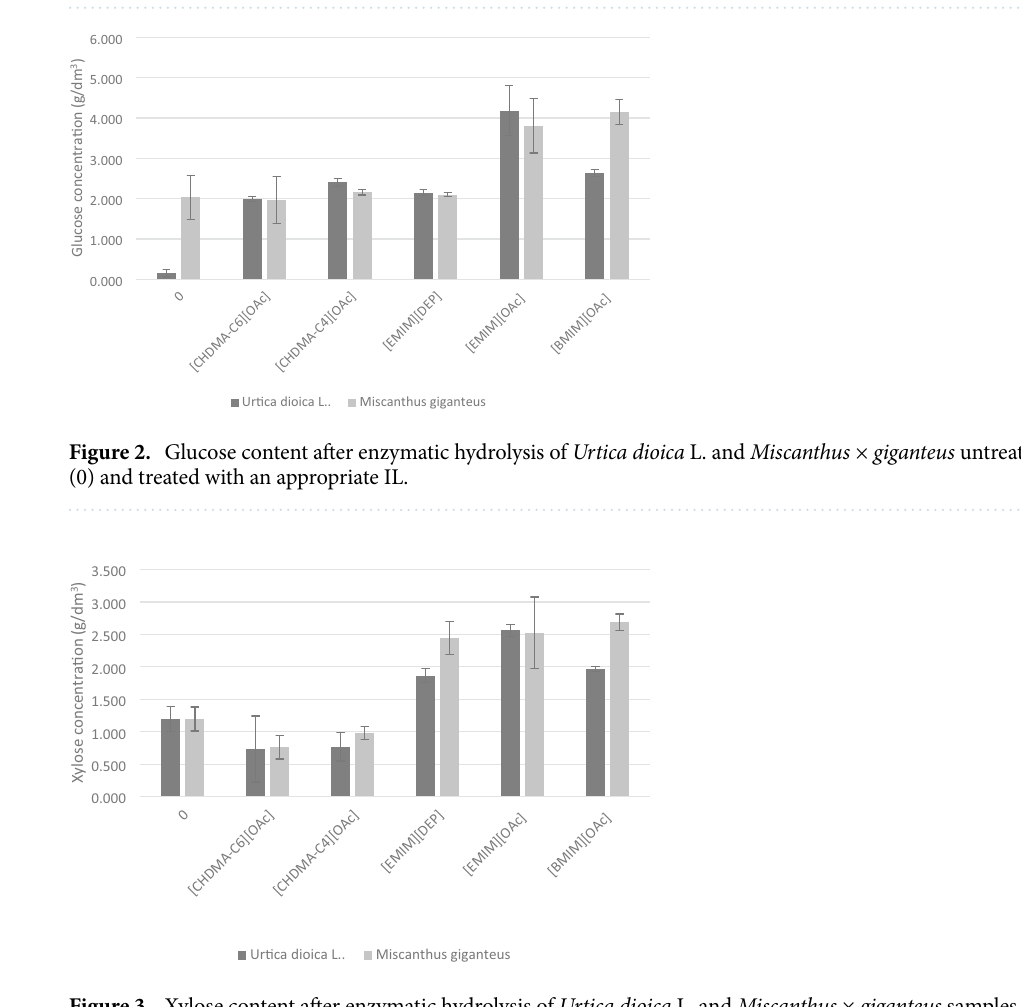
Figure 3. Xylose content after enzymatic hydrolysis of Urtica dioica L. and Miscanthus × giganteus samples untreated (0) and treated with an appropriate